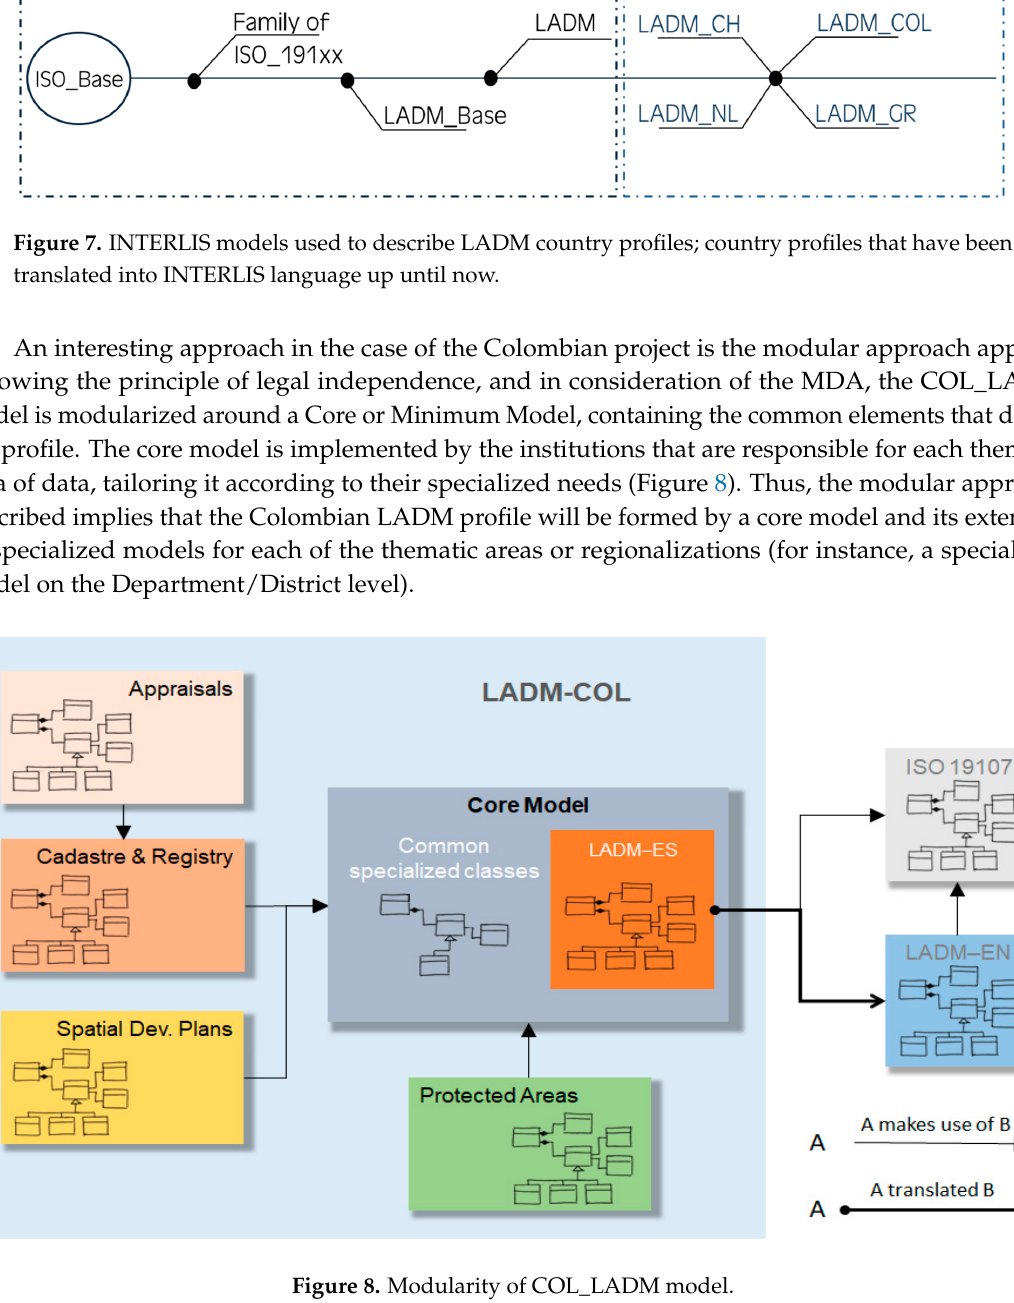
Figure 7. INTERLIS models used to describe LADM country profiles; country profiles that have been translated into INTERLIS language up until now.